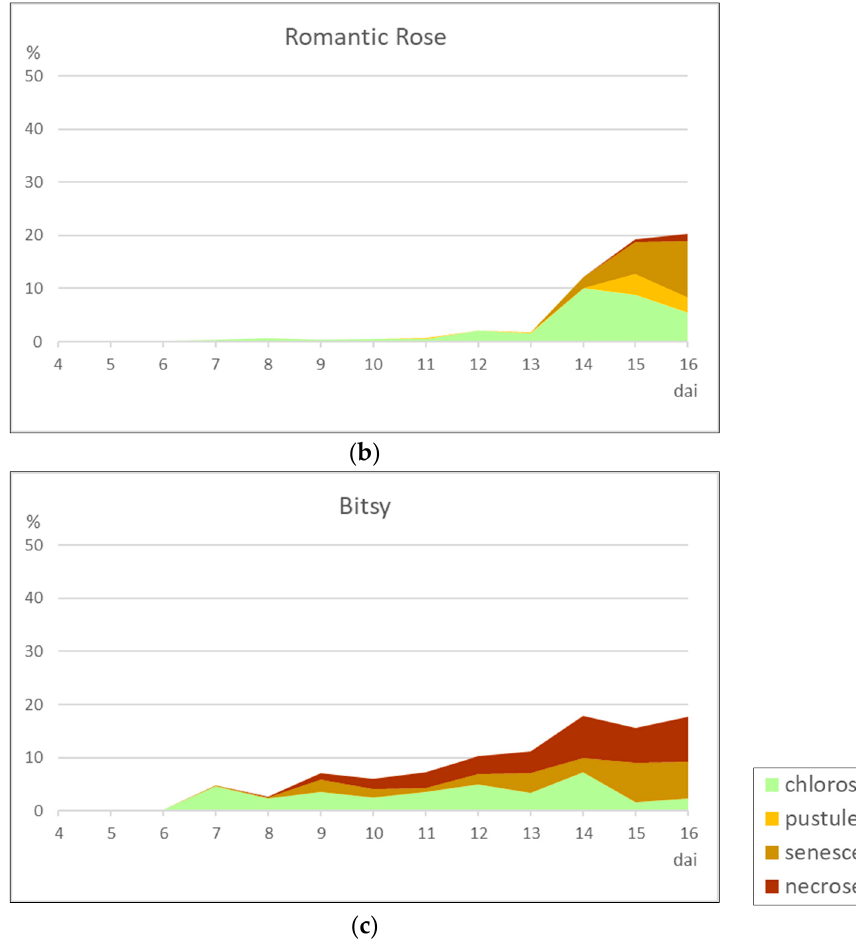
Figure 6. Area under the disease progression curve obtained in susceptible ( a ), moderately susceptible ( b ) and moderately resistant ( c ) interactions between daylilies and Puccinia hemerocallidis up to 16 days after inoculation (dai).